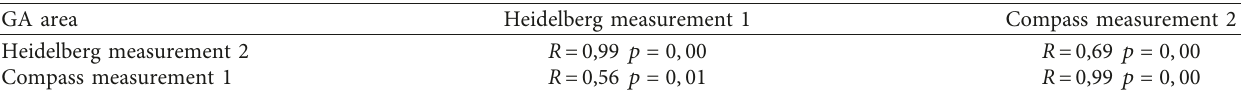
Table 2: Pearson’s correlation between intraobserver GA measurements (measurements 1 and 2) and between CMP and Heidelberg IR imaging.